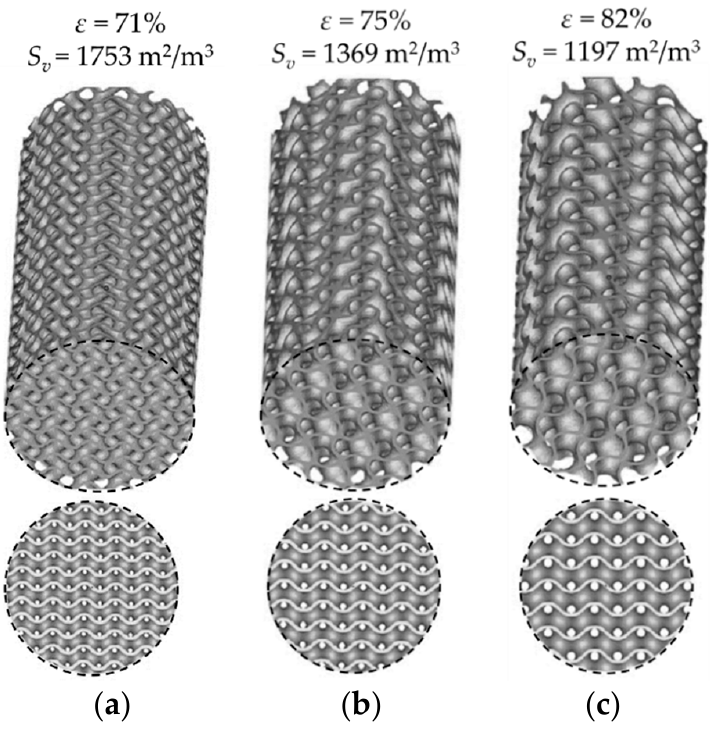
Figure 18 . The sheet-Gyroid structures with different unit cell sizes at the same thickness of 0.6 mm: ( a ) L = 4 mm; ( b ) L = 5 mm; ( c ) L = 6 mm [74].